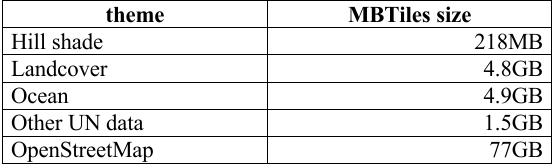
Table 3. Size of produced MBTiles